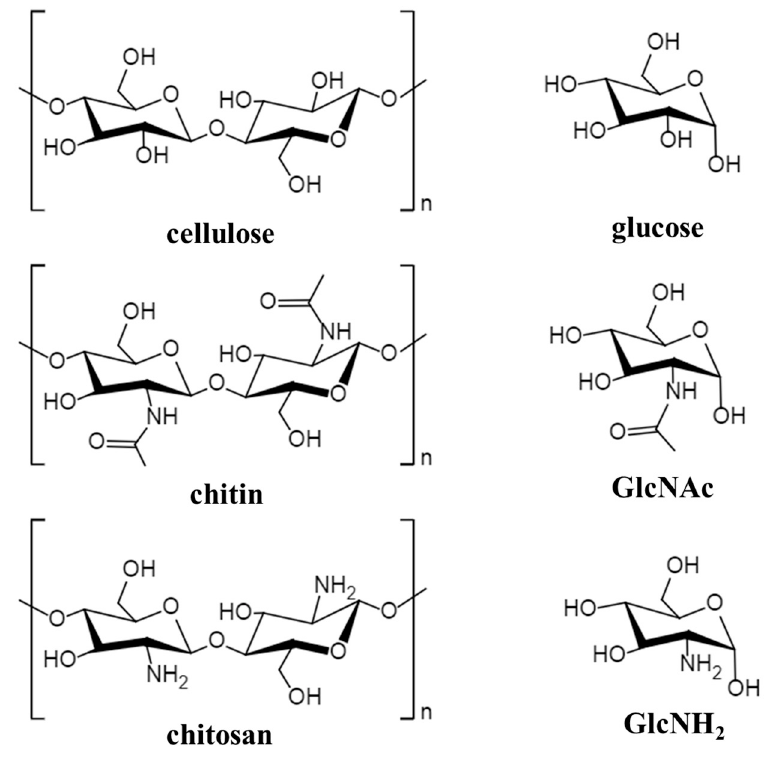
Figure 2. Chemical structure of cellulose, chitin, and chitosan and their corresponding monomers.